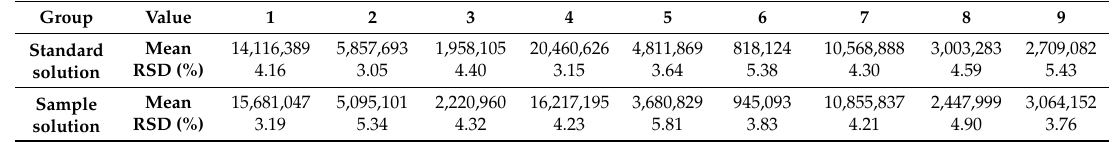
Table 3. Stability of the method for the determination of the nine analytes.